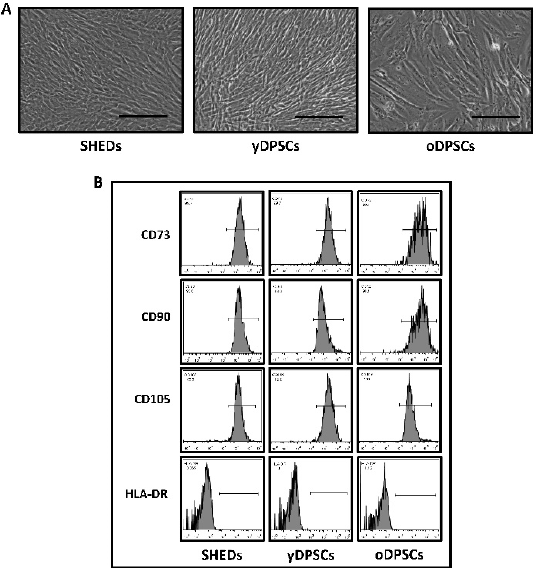
Figure 1. Characterization of dental pulp stem cells from different age groups. ( A ) Morphology of SHEDs, yDPSCs, and oDPSCs at Passage 4. ( B ) Analysis of a cluster of differentiation markers CD73, CD90, CD105, and HLA-DR by flow cytometry on SHEDs, yDPSCs, and oDPSCs ( n = 5). Scale bar = 100 μm. SHEDs: Stem cells from exfoliated deciduous tooth, yDPSCs: Dental pulp stem cells from young subjects, oDPSCs: Dental pulp stem cells from old subjects.